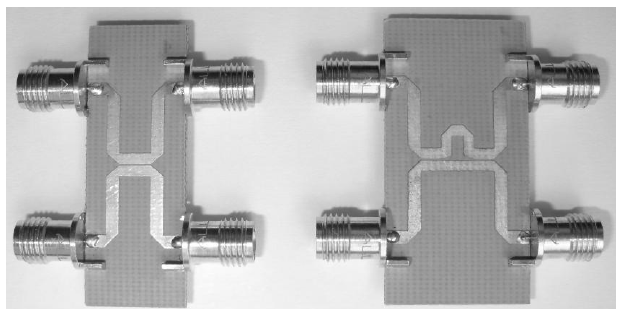
Figure 4. Photo of the realized prototypes. Right : directional coupler of Figure 2 with the parameters of Table 1; left : Standard quarter-wave, coupled-line-directional coupler (SC) with the same inter-line spacing S .